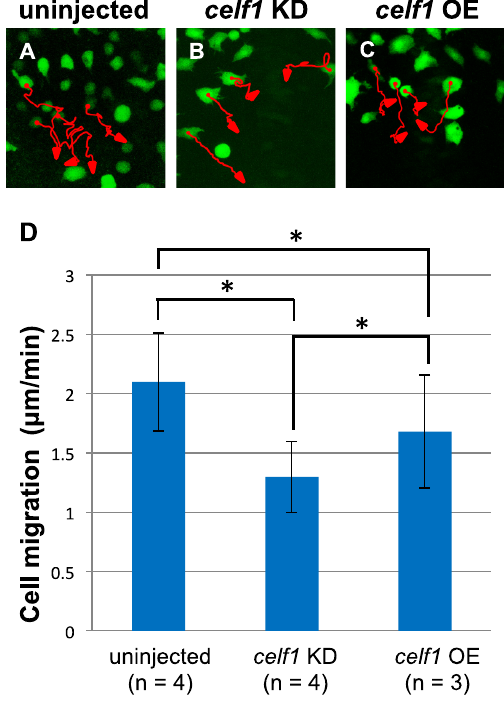
Figure 4. celf1 regulates migration of endoderm cells during gastrulation. ( A – C ) The migration tracks individual endoderm cells in a period of 80 min in uninjected ( A ), celf1 KD ( B ) or celf1 overexpressing (OE) embryos ( C ). The cell position was determined every two minutes. Each red arrow indicates the trajectory of the cell migration. ( D ) Migration of endoderm cells ( n = 58, 59 or 50) in uninjected ( n = 4), celf1 KD ( n = 4) or celf1 OE embryos ( n = 3). The speed of cell migration in celf1 KD embryos became slower than that of the uninjected control. Statistically significant differences (* p < 0.05) could be seen in control vs. celf1 KD